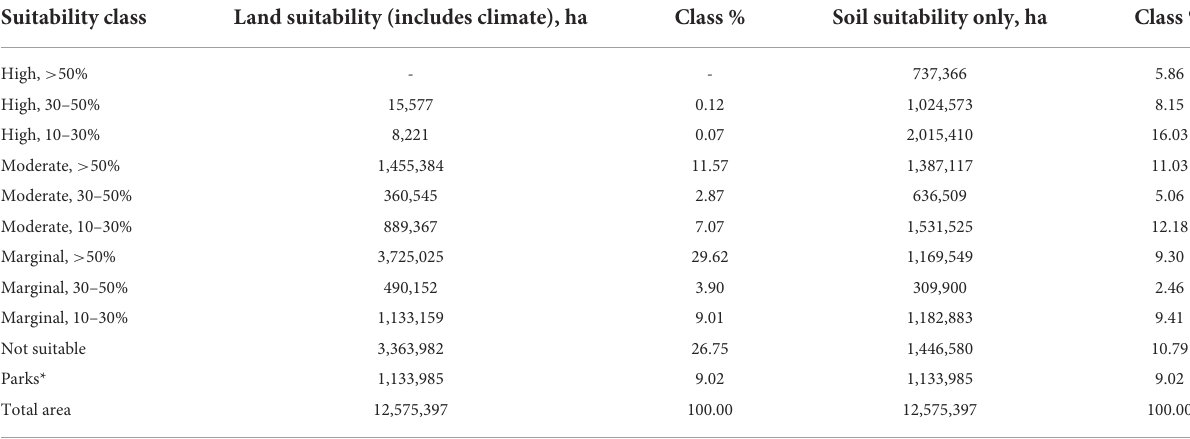
TABLE 4 Bambara groundnut soil and land suitability classes.